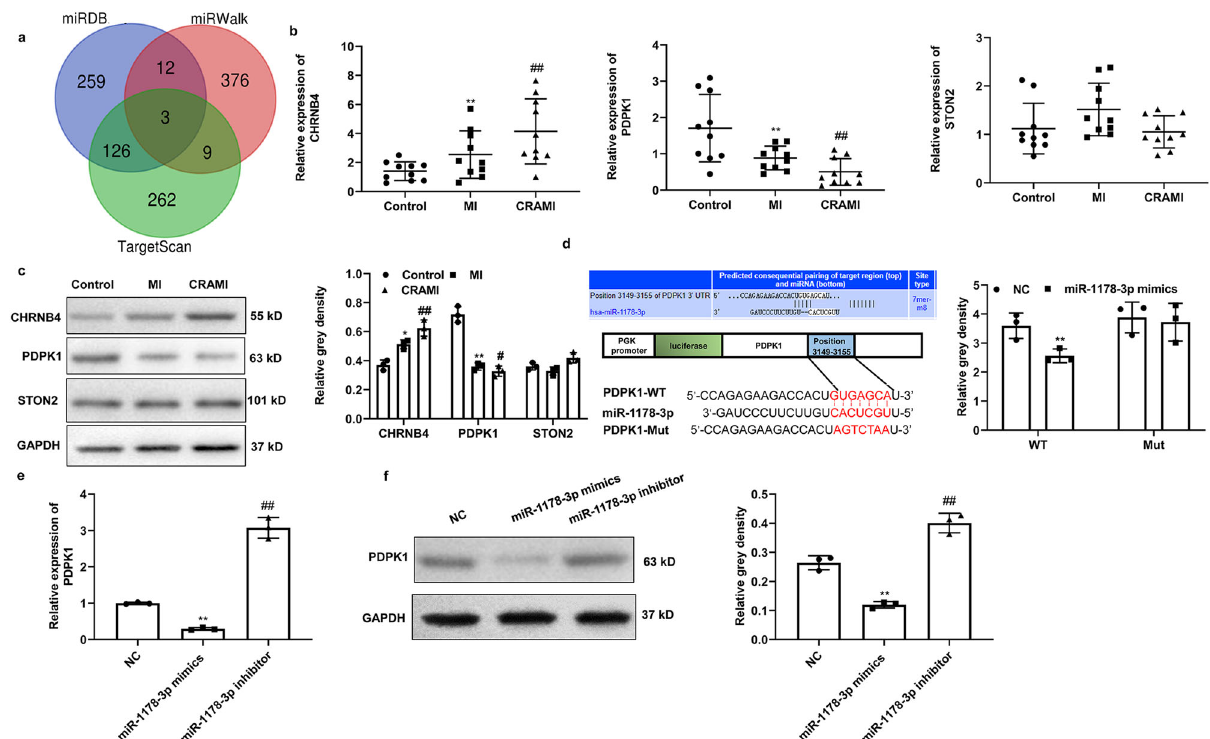
Fig. 6 PDPK1 is the target of miR-1178-3p. a Targets of miR-1178-3p were predicted by the online databases TargetScan7.2, miRwalk and miRDB; b , c The qPCR and western blotting analysis were used to detect the expression of PDPK1, CHRNB4 and STON2 in the serum of patients with and without postinfarct cardiac remodeling, respectively. GAPDH served as control. Data are mean ± SD. ** P < 0.01, N-CR group vs. Control group; ## P < 0.01, CR group vs. N-CR group. CR, postinfarct cardiac remodeling; N-CR, nonpostinfarct cardiac remodeling. d Luciferase reporter assays to verify the binding of miR-1178-3p to PDPK1 at the 3'UTR; e , f Expression of PDPK1 was detected using qRT – PCR and western blotting in VSMCs treated with miR-1178-3p mimics or inhibitors at the mRNA and protein levels, respectively. Data are mean ± SD. ** P < 0.01, miR-1178-3p mimics group vs. NC group; ## P < 0.01, miR-1178-3p inhibitor group vs. NC